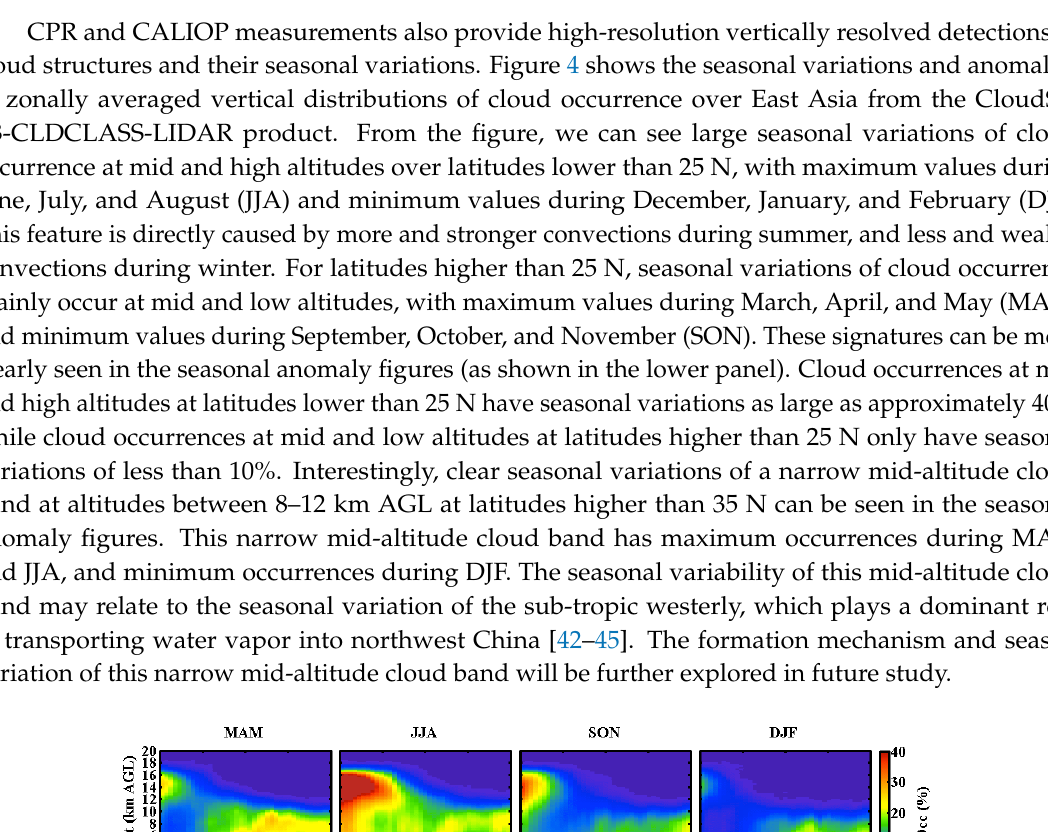
Figure 3. ( a ) Zonally averaged vertical distributions of cloud occurrences over East Asia from the CloudSat 2B-CLDCLASS-LIDAR product; ( b ) differences of cloud occurrence frequencies between the CloudSat 2B-CLDCLASS-LIDAR product and the CALIOP Level 2 5-km cloud layer product; ( c ) differences between the CloudSat 2B-CLDCLASS-LIDAR product and the 2B-GEOPROF product.